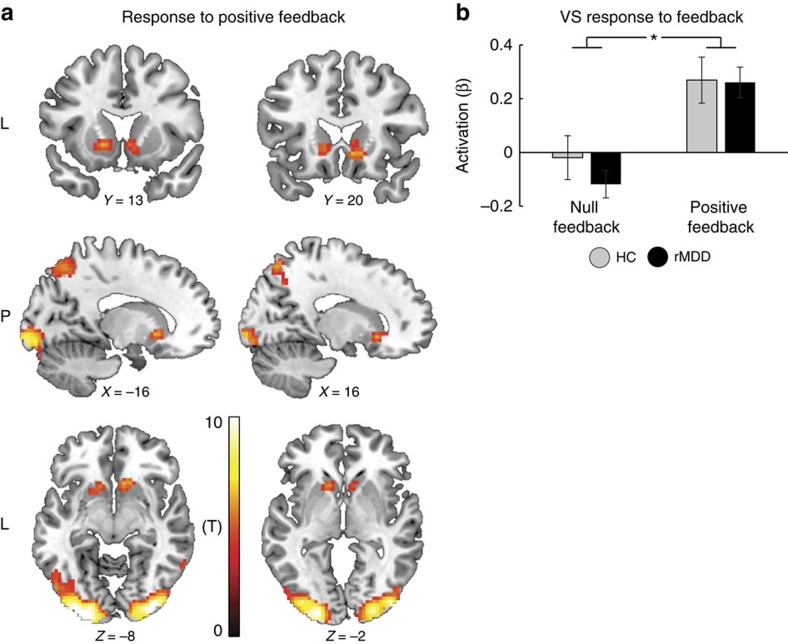
Acute neural responses to the positive feedback.(a) A whole-brain analysis across groups revealed increased activation in bilateral VS as well as in visual occipital areas in response to the positive feedback compared with null feedback at a significance level adjusted such that Type I error was controlled for all voxels in the brain using the false discovery rate (FDR), with q=0.05 in more than 10 contiguous voxels. (b) Mixed ANOVA revealed that both groups responded to the positive feedback with increased VS activation. Bars ±1 s.e.m. *P<0.05. HC, healthy controls (n=25); rMDD, remitted individuals with a history of recurrent MDD (n=25); VS, ventral striatum.